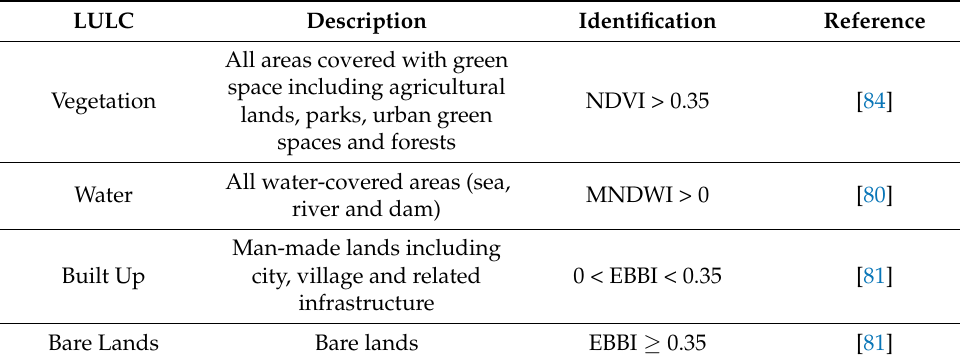
Figure 4. Classification process of satellite images used in the study. Table 2. Different types of land use/cover classes and related indices in the studied